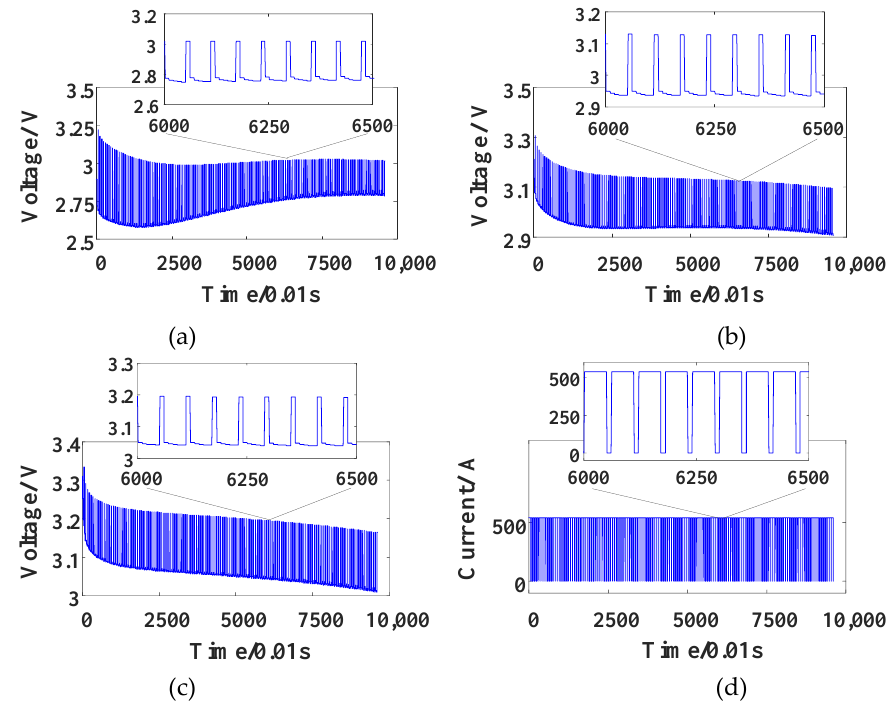
Figure 6. Voltage and current profiles of high rate pulse discharge conditions: ( a ) voltage at 0 °C; ( b ) voltage at 25 °C; ( c ) voltage at 45 °C; ( d ) current.